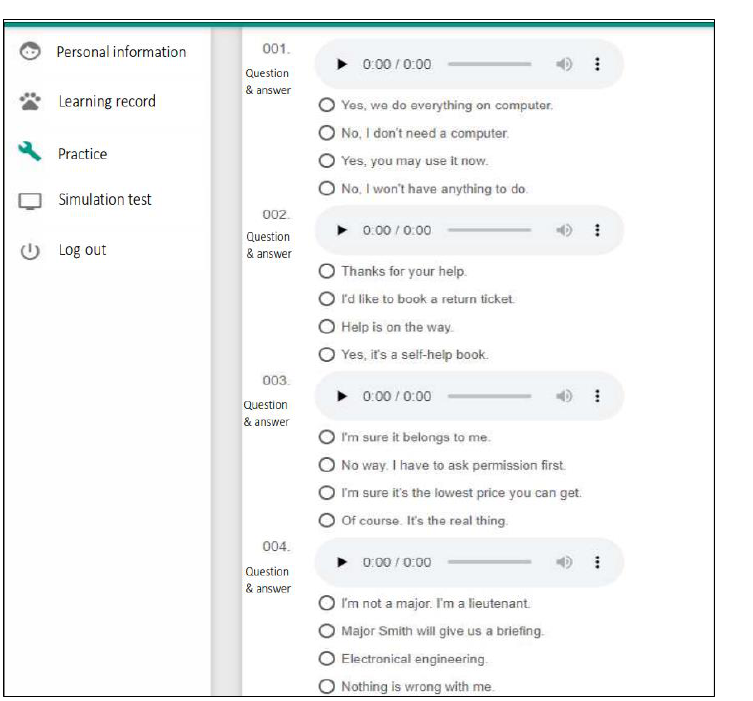
Figure 4. MOEPT operating interface on the Internet.